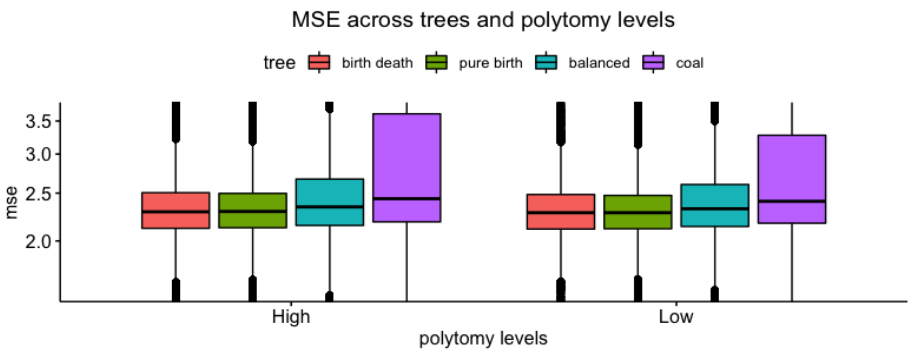
Figure 14. Comparison of MSE across tree type and polytomy